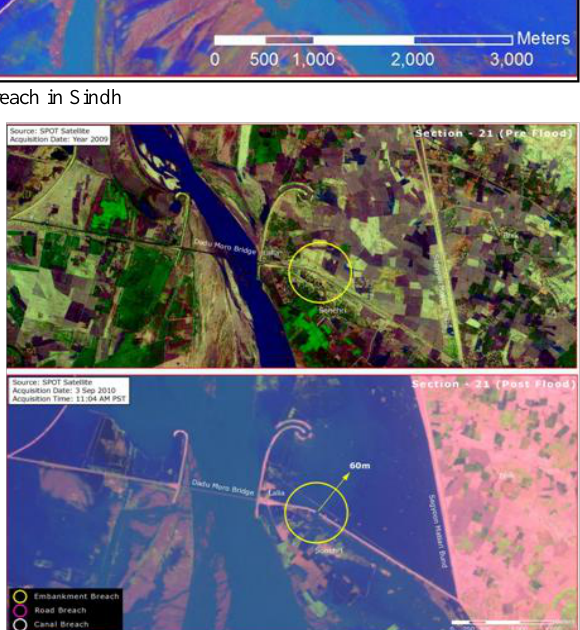
Figure 4. . Dadu-Moro Road Breach,